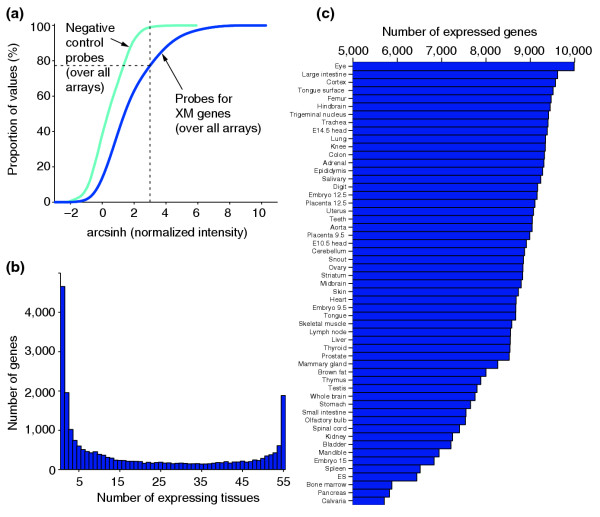
Defining whether a gene is expressed, and how many genes are detected as expressed per sample. (a) The curves show the cumulative distribution for negative-control probes (cyan line) and for probes on the array (blue line), over all arrays, to illustrate how genes were defined as expressed. The dotted black line indicates the 99thpercentile for the negative control spots. (b) The number of genes expressed in any given number of tissues (between 1 tissue and 55 tissues; for example, there are 4,475 genes detected in only one sample, 171 genes expressed in exactly 27 samples, 1,790 genes detected in all 55 samples, and so on). The genes expressed in each of the 55 tissues were determined as in (a). (c) Number of genes defined as expressed in each of the 55 tissues, using criteria in (a).